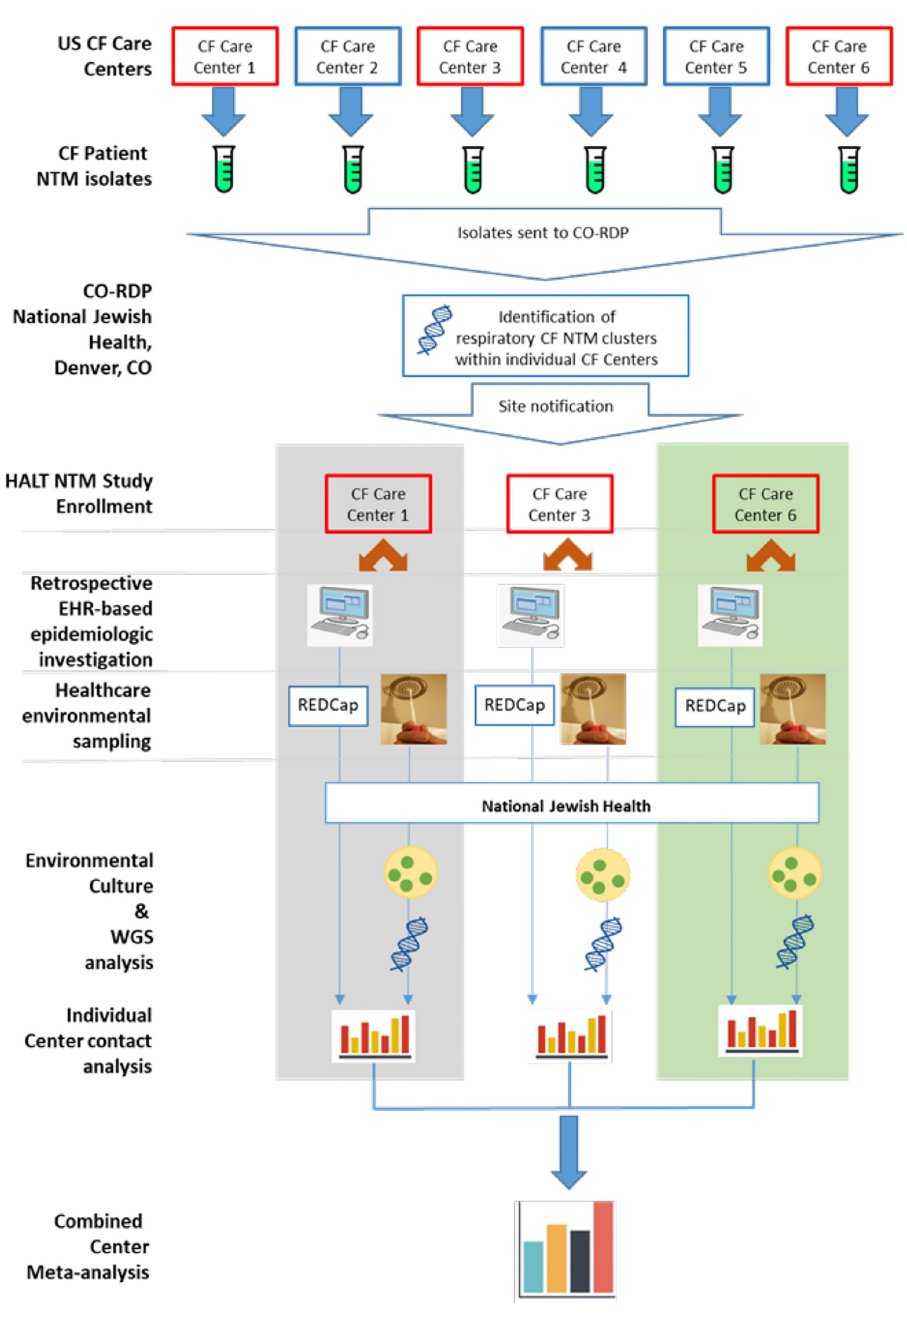
Fig 2. Schematic showing an overview of the parallel multi-site study design. of NTM isolates, defined as highly similar strains at the genomic level, harbored by two or more pwCF who are cared for at the same CF Care Center [27, 31]. Highly-related clusters of NTM are defined as less than or equal to 20 or 30 single-nucleotide polymorphism (SNP) dif- ferences at the core genome level, for M . avium and M . abscessus , respectively. All CF Care Centers that have clusters of highly-related NTM isolates are offered enrollment in HALT NTM. Subject enrollment is unlimited and based on the number of pwCF identified in an